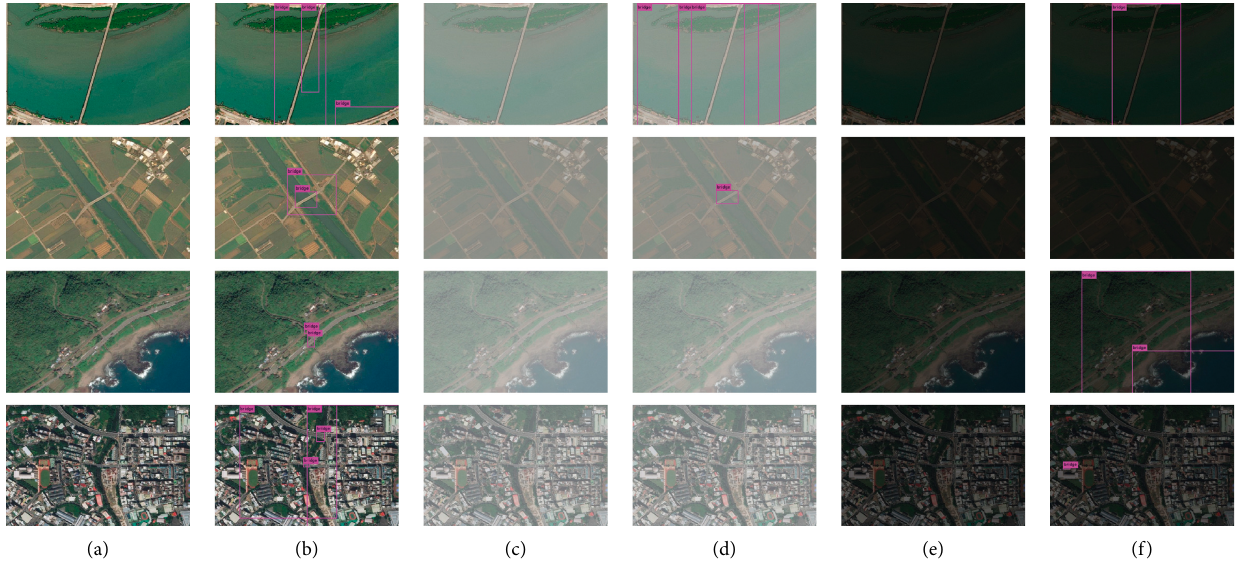
Figure 13: The comparisons of YOLOv4 network under normal, hazy and low-light imaging conditions. (a) Original. (b) Origi-